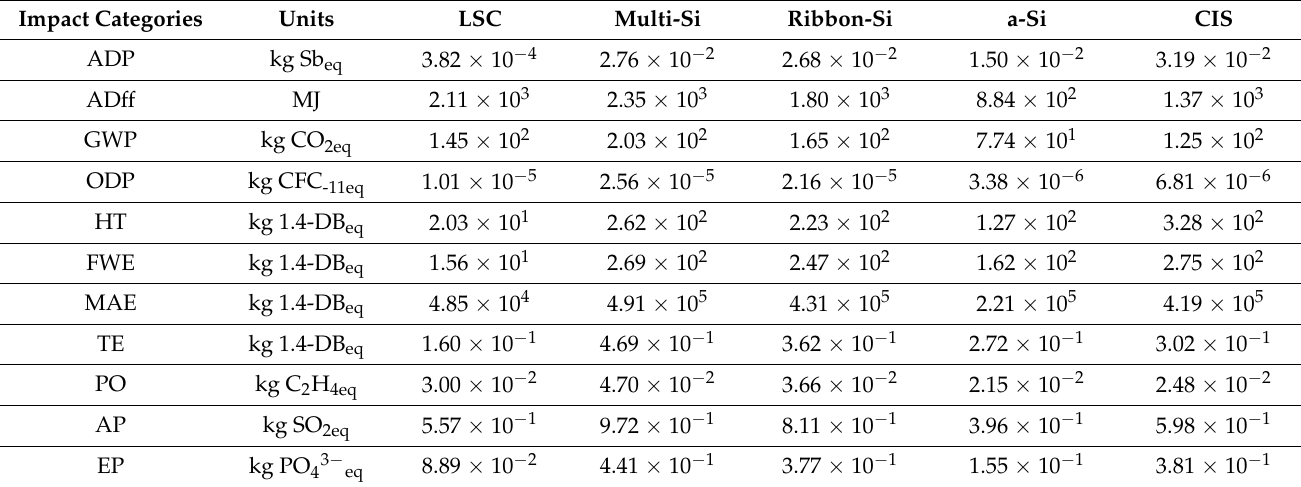
Table 4. Environmental impacts comparison between different PV modules (1 m 2